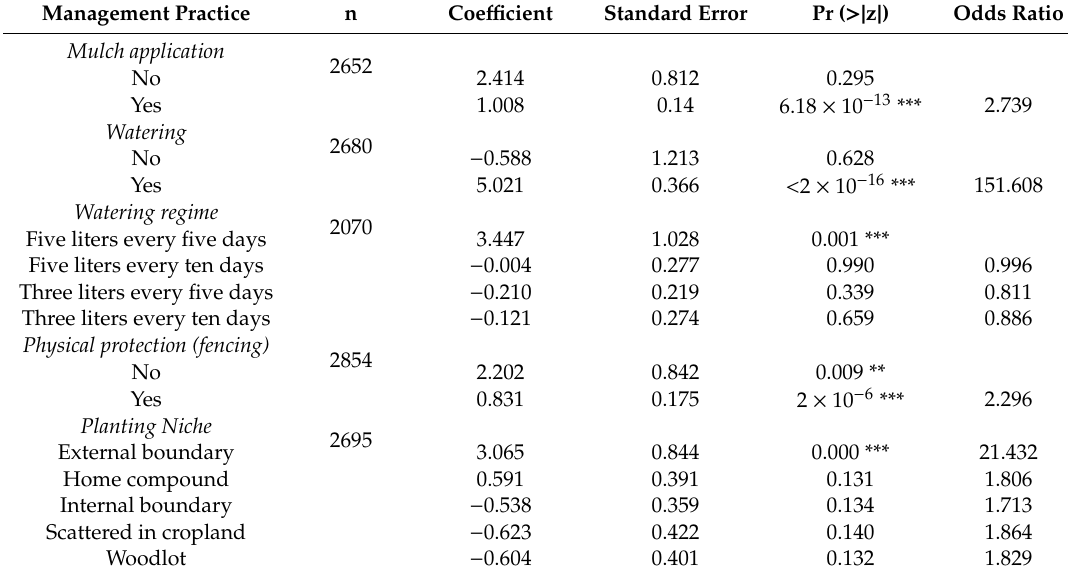
Table 5. Results of a logistic model on the probability of seedling survival under di ff erent planting